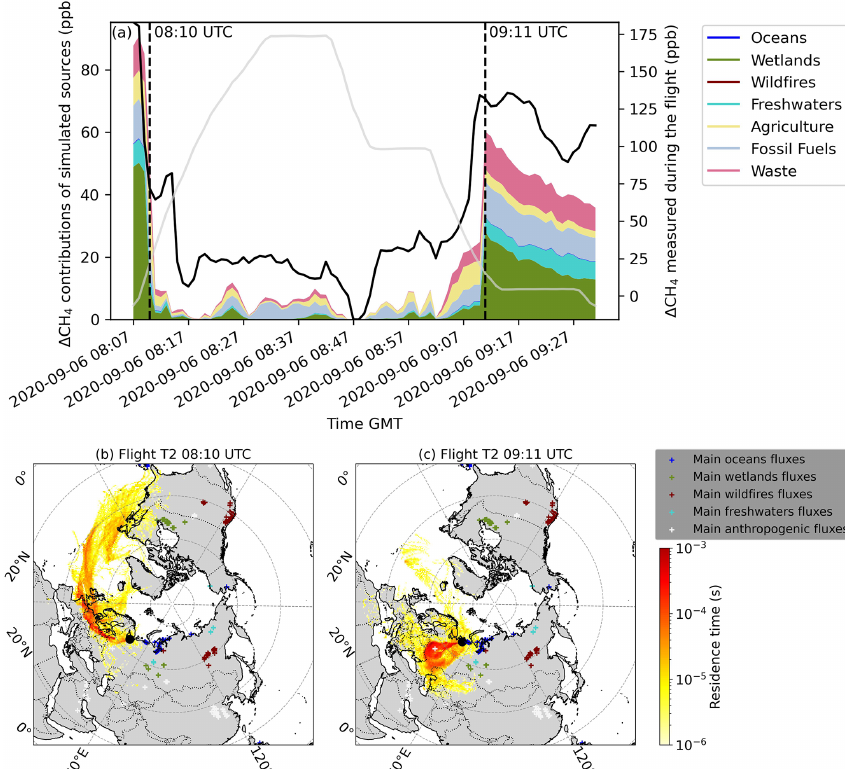
Figure 10. (a) Simulated CH 4 enhancement (colored stacked plot) and measured CH 4 (black line) for flight T2. Note the different y axes. Altitude is shown in gray (bottom at 12 and top at 8963m). The two vertical dotted lines indicate the measurements represented in the following footprints. (b) The 10d potential emission sensitivity (PES) for particles released at 08:10UTC. (c) Same as (b) at 09:11UTC. The colored “ + ” symbols represent the fluxes with the biggest intensities derived from each inventory. The black dot represents the receptor